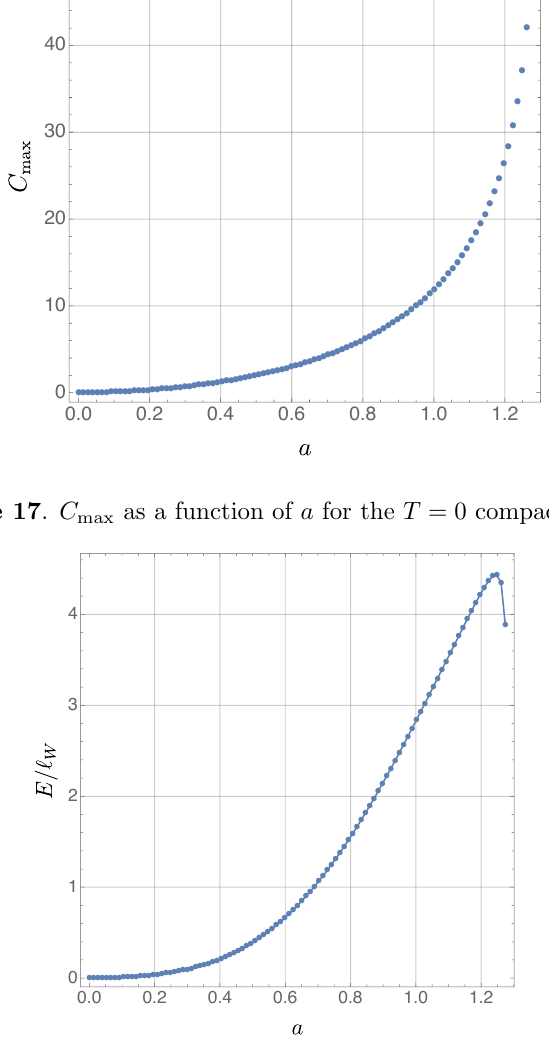
Figure 18 . The energy density E=‘ W as a function of a , with the non-monotonic behaviour starting at around a (cid:25) 1 :